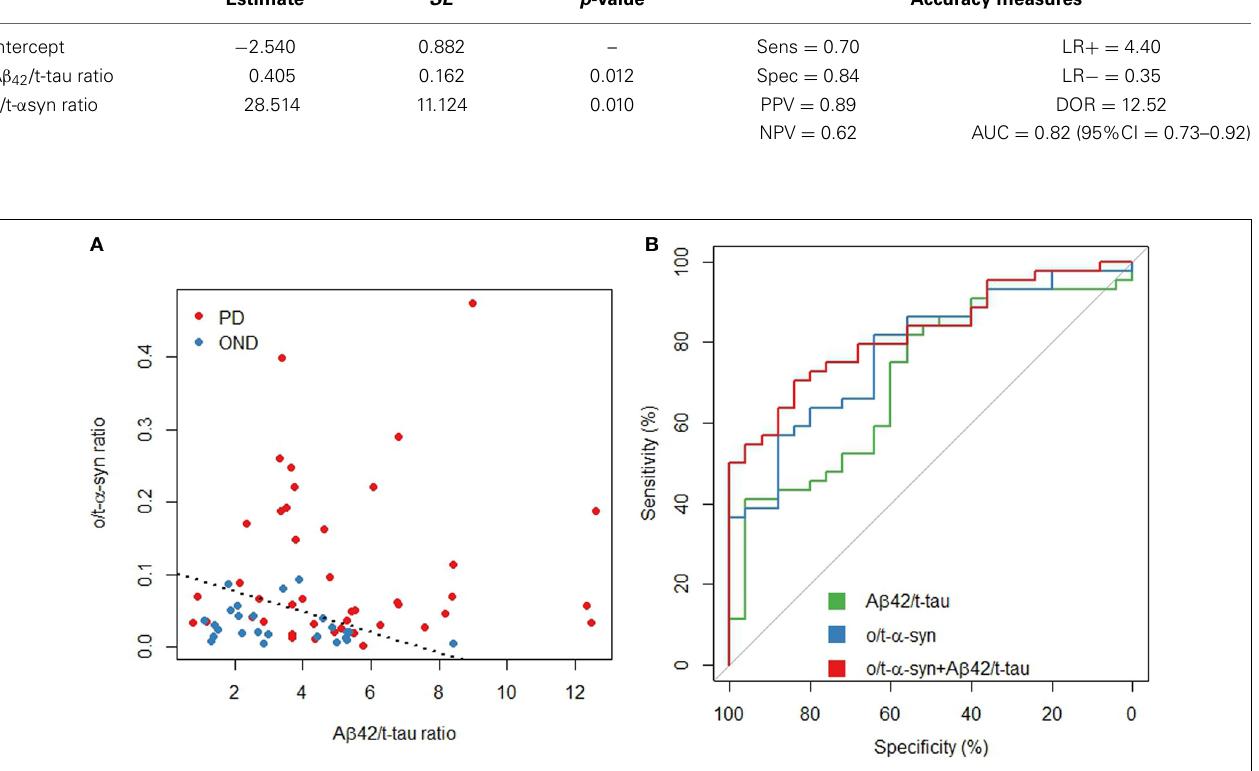
FIGURE 2 | A β 42 /t-tau and o/t- α -syn ratios in PD and OND. (A) Scatterplot: the dashed line represents a partition of the o/t- α -syn and A β 42 /t-tau space such that below the line the model predicts OND,